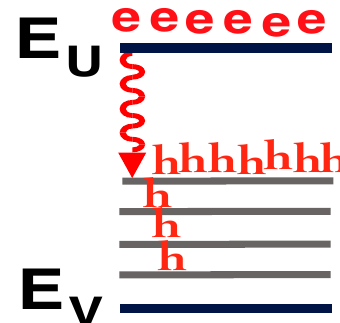
Figure 22 . Electron and hole population distribution in Samples H–N (with resonant cavity). In the presence of a resonant cavity, Figures 15 to 19 show that the hole population remains pinned in midgap states for all injections above threshold. The hole population in deep-levels no longer increases with increasing injection. Hence, the rate of radiative recombination of holes with electrons is greater than in Figure